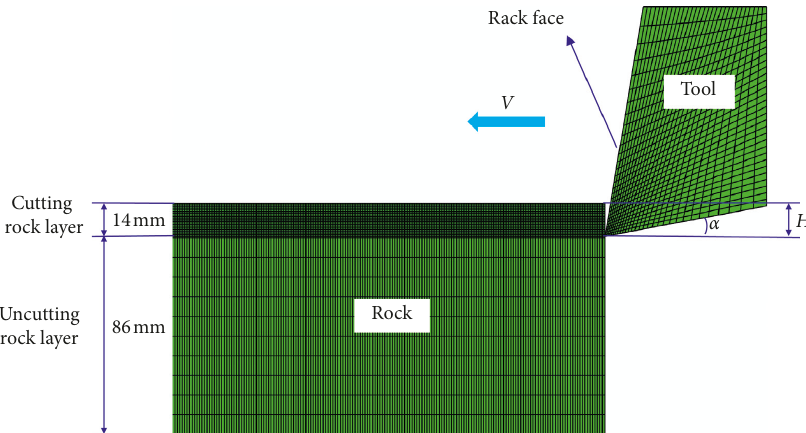
Figure 2: Schematic simulation model of the rock cutting (back angle α � 5–20 ° , cutting depth H � 8–14 mm, and cutting speed V � 0.46–1.90